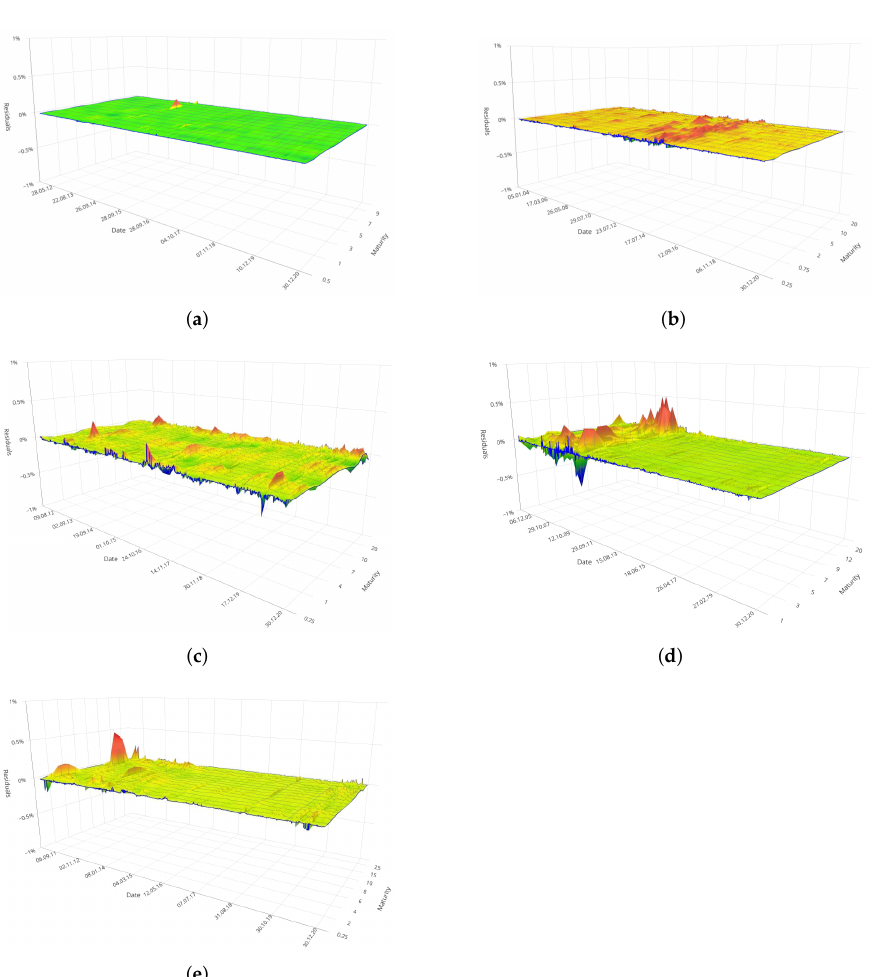
Figure 7. Surface of daily residuals for the yield curve obtained with the 5F–DRF in the BRICS bond market of Brazil ( a ), Russia ( b ), India ( c ), China ( d ), South Africa ( e